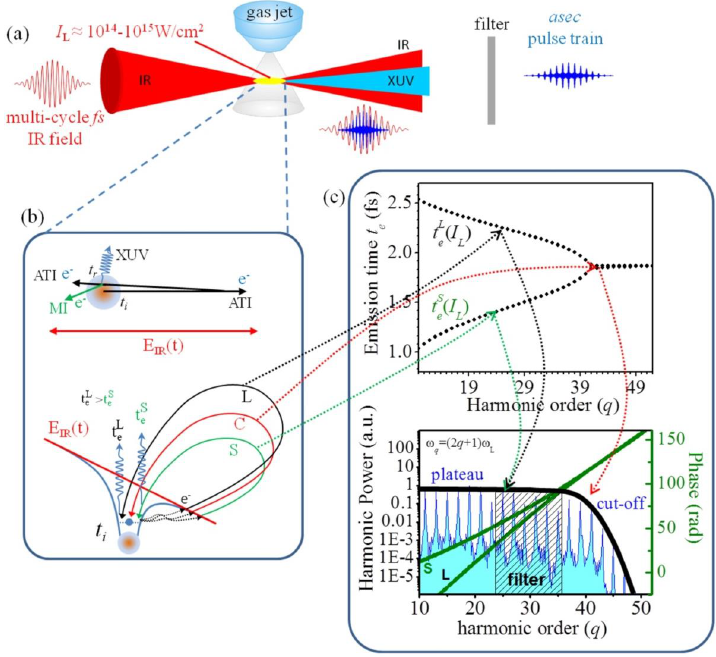
Figure 1. ( a ) A schematic representation of High-order harmonic generation (HOHG) in gas-phase media; ( b ) (upper panel) An oversimplified picture of the recollision process. t i , t r , MI, XUV, ATI are the ionization time, recollision time, multiple ionization, generation of XUV radiation and ATI photoelectrons, respectively. The red arrow shows the polarization direction of the driving field and the black line the electron trajectory; (down panel) High-order-harmonic generation process in the spirit of three-step model. L (black line), S (green line) show the “Long” and “Short” electron trajectories contribute to the plateau harmonic emission, respectively. t eL and t eS are the corresponding emission times. C (red line) shows the electron trajectory contribute to the cut-off harmonic emission; ( c ) (upper panel) Emission times as a function of the harmonic order (calculated using the semi-classical 3-step model for I L = 2 × 10 14 W/cm 2 and I P = 15 eV, and λ = 800 nm). t eL ( I L ) and t eS ( I L ) depict the emission times (which depend on I L ) corresponding the “Long” and “Short” trajectory harmonics. In the spirit of semi-classical 3-step model the emission times is the real part of the recombination time t r . (down panel) Calculated harmonic spectrum (blue filled area) with ω q = (2 q + 1)ω L (where ω L is the frequency of the IR field). The “Long” and “Short” trajectory harmonics, which contribute in plateau region, degenerate to a single trajectory in the cut-off region of the spectrum. The green solid line is the spectral phase distribution of the S and L trajectory harmonics. The black solid line illustrates the XUV continuum spectrum emitted in case of a single electron recollision. The line-shaded area illustrates the bandwidth of the XUV radiation which passes through a band pass XUV filter.